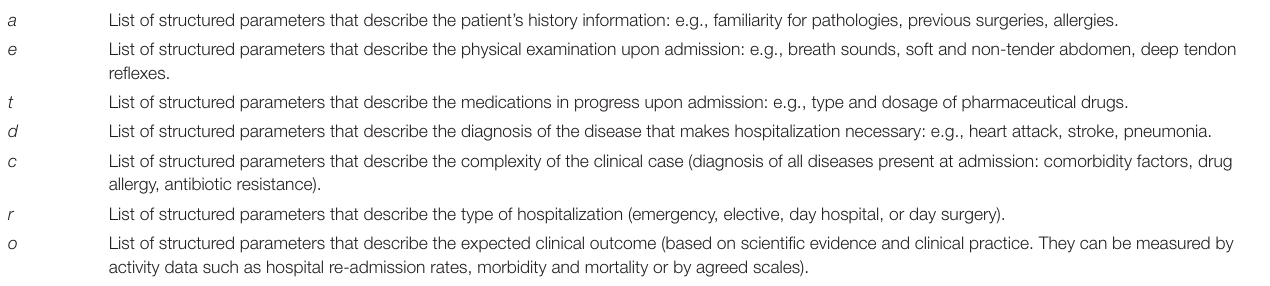
TABLE 1 | Example parameters describing the initial conditions of the patient.